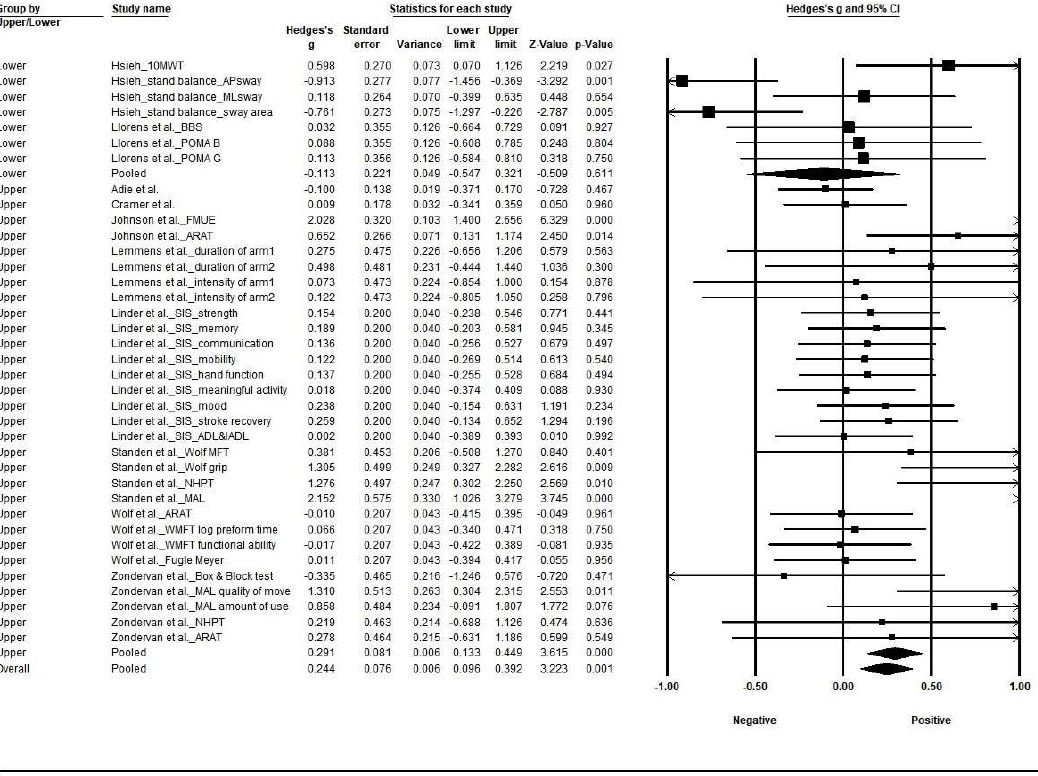
Figure 4. Forest plot by applied limb. Abbreviations: 10MWT, 10-Meter Walking Test; AP, anterior– posterior; ML, medial–lateral; SIS, Stroke Impact Scale; (I)ADL, (Instrumental) Activity in Daily Life; ARAT, Action Research Arm Test; BBS, Brunel Balance Assessment; POMA B, Performance-Oriented Mobility Assessment-Balance; POMA G, Performance-Oriented Mobility Assessment-Gait; MFT, Motor Function Test; NHPT, Nine-Hole Peg Test; MAL, Motor Activity Log. (squares and circle shows a mean of effect size, arrow presents the 95% confidential interval). Summary of Figure 4: The effect sizes, Hedges’s g, were − 0.113 ( p = 0.750) in the lower limbs [14,20]